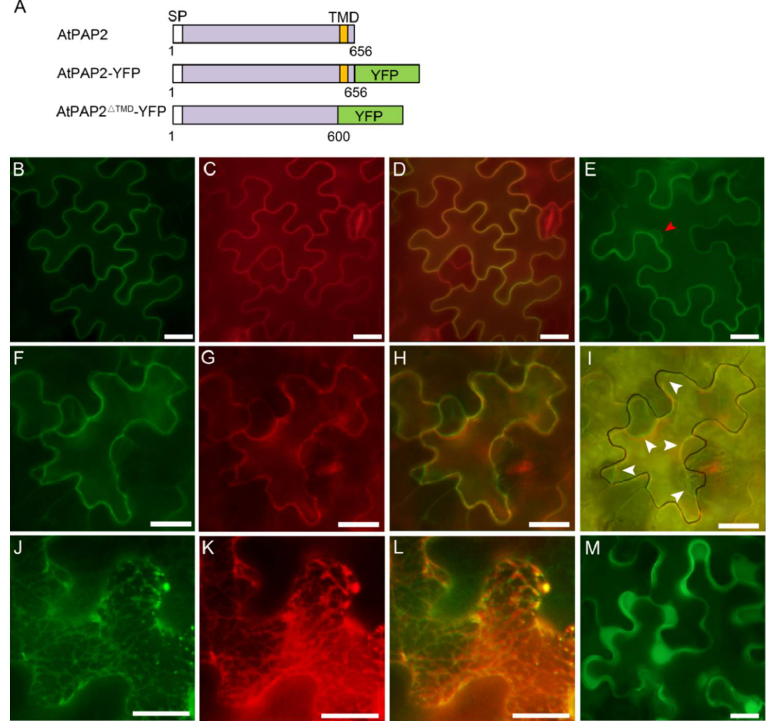
Figure 2. Subcellular localization of AtPAP2-YFP and AtPAP2 ∆TMD -YFP in tobacco epidermal cells. ( A ) Schematic diagram of the AtPAP2-YFP and AtPAP2 ∆TMD -YFP fusion constructs; ( B – L ) The full length and the first 600 aa without the TMD of AtPAP2 with a yellow fluorescent protein